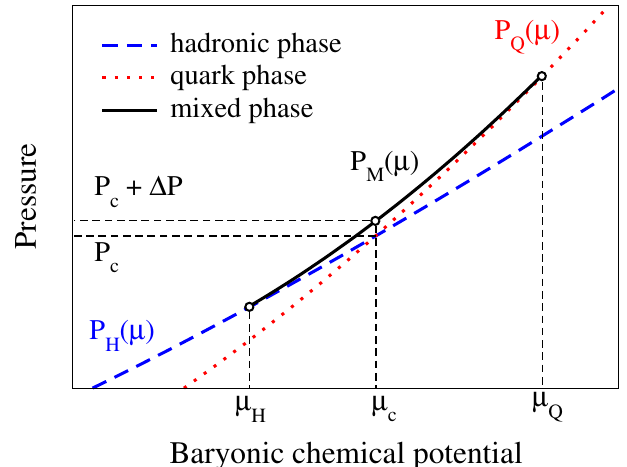
Figure 1. Schematic representation of the interpolation function P M ( µ ) obtained from the mixed phase constructions discussed in this work. For both interpolation methods discussed in the text it has to go though three points: P H ( µ H ) , P c + ∆ P and P Q ( µ Q )